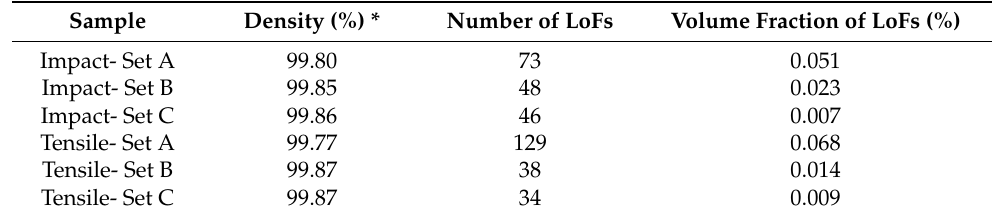
Table 3. Density of specimens (including both border and core regions), number, and volume fraction of LoFs present in the impact and tensile specimens.